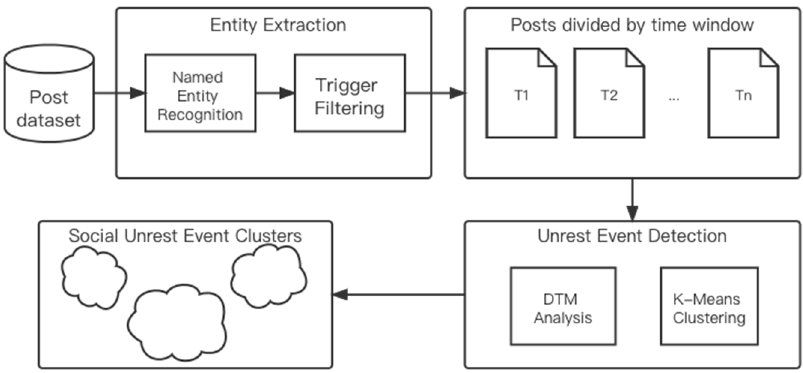
Figure 1. Integration framework on social unrest event detection.